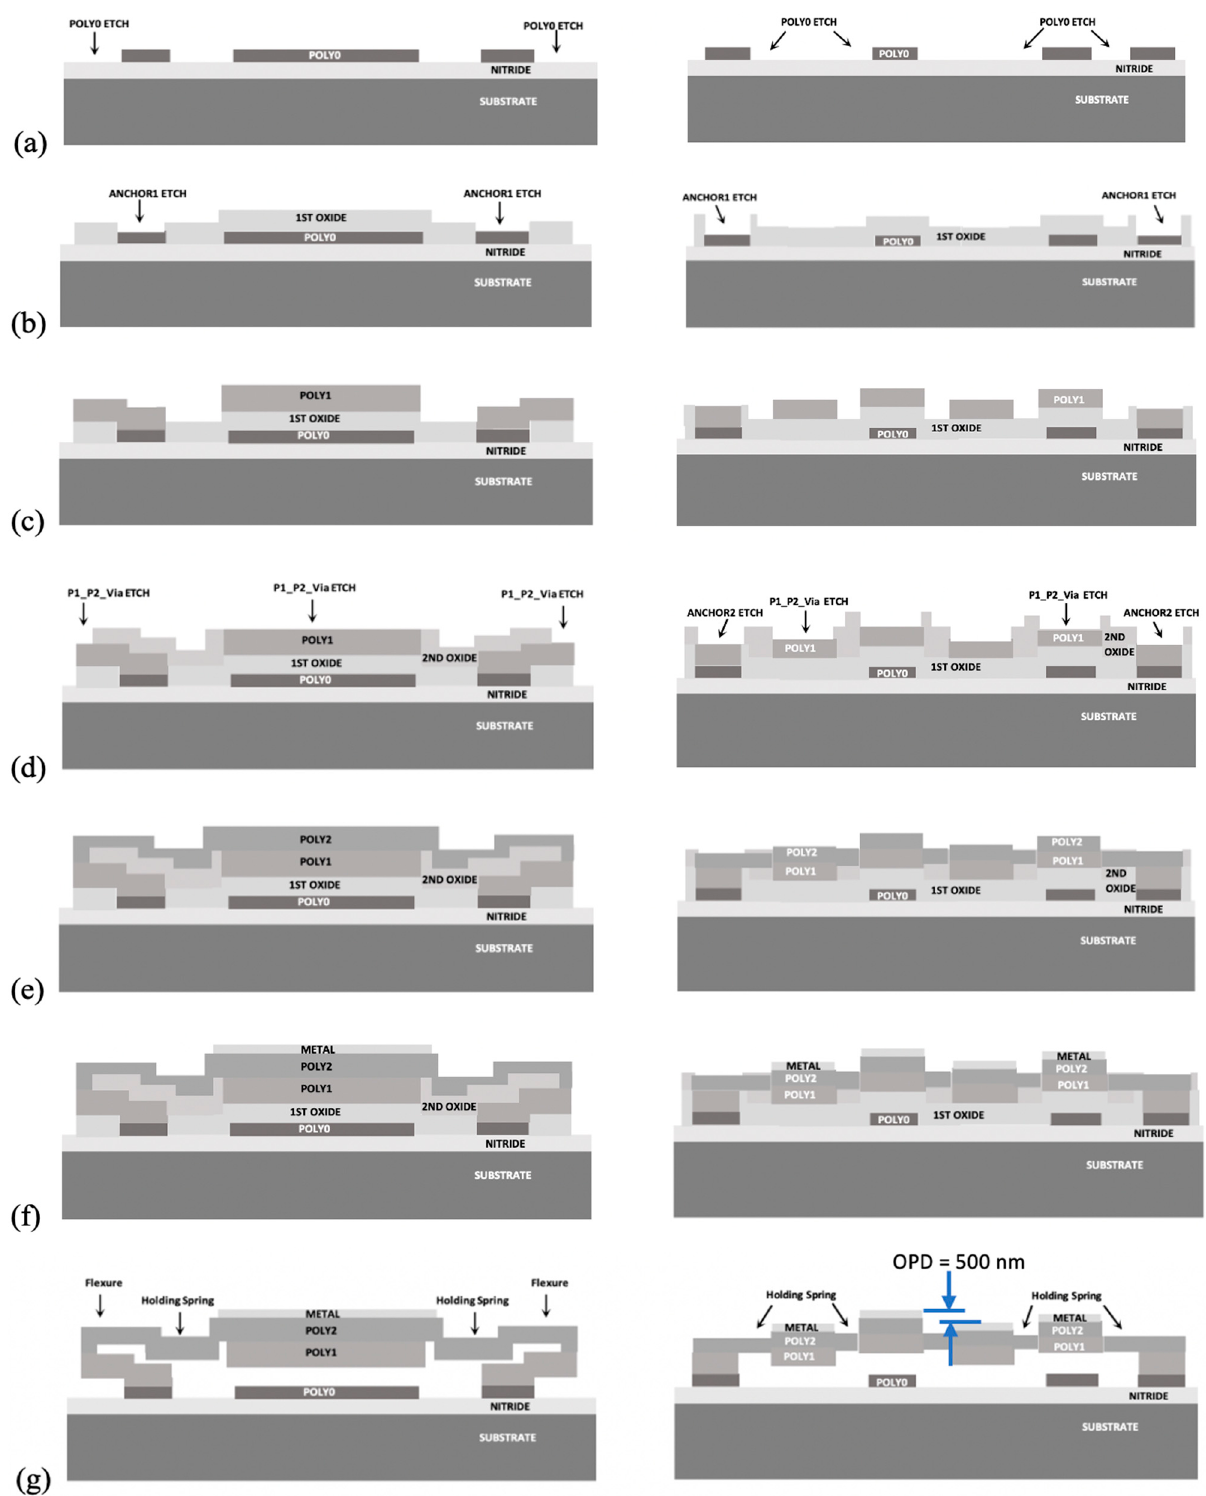
Figure 4. Schematic diagram showing details of the fabrication process for the pitch-tuning OPA micromirrors: ( a ) doped polysilicon bottom electrodes and GND (ground) layer; ( b ) bottom sacrificial oxide layer and DRIE of features; ( c ) second polysilicon layer for bottom parts of the mirror beam and the folded-beam flexure structures; ( d ) top sacrificial oxide layer and DRIE of features; ( e ) third polysilicon layer for the remaining parts of the mirror beams and spring structures; ( f ) gold metallization layer for the top mirror reflective surface; ( g ) HF release resulting in the free-standing structure.